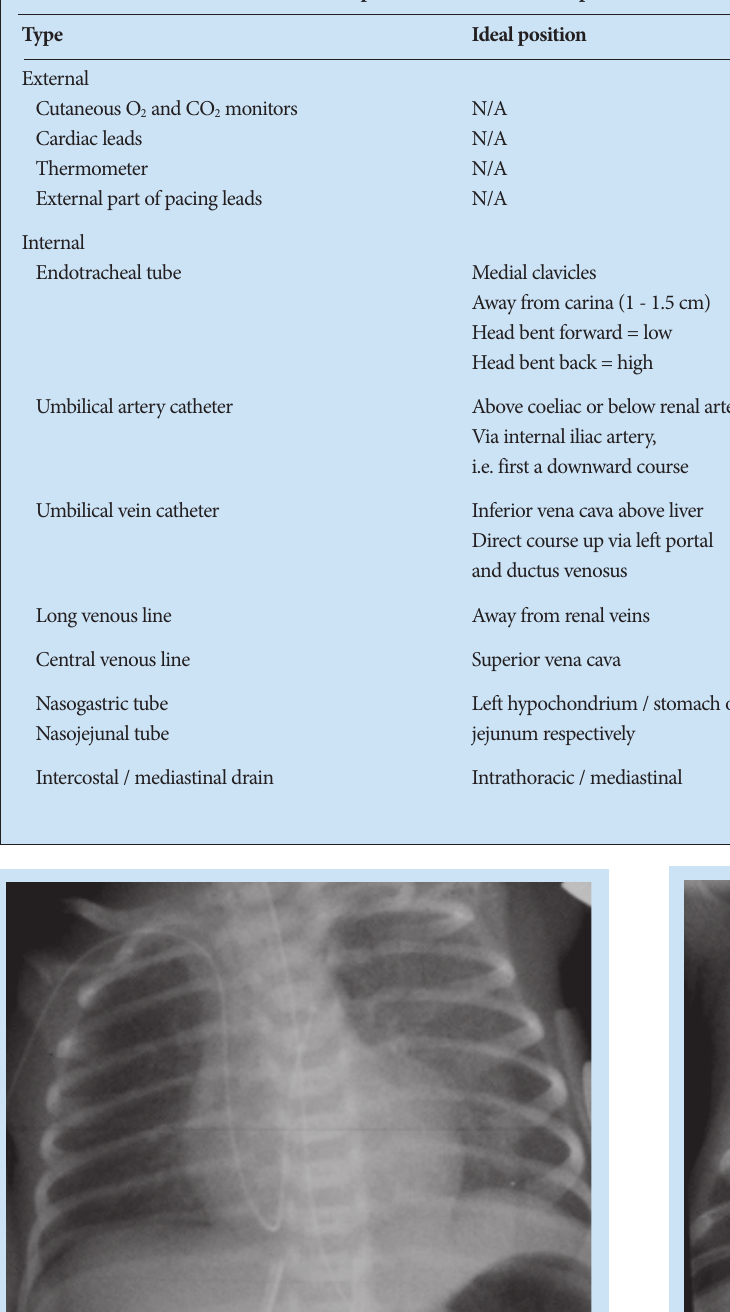
Table I. Ideal positions and undesirable positions for lines and tubes on neonatal chest X-rays 1,8